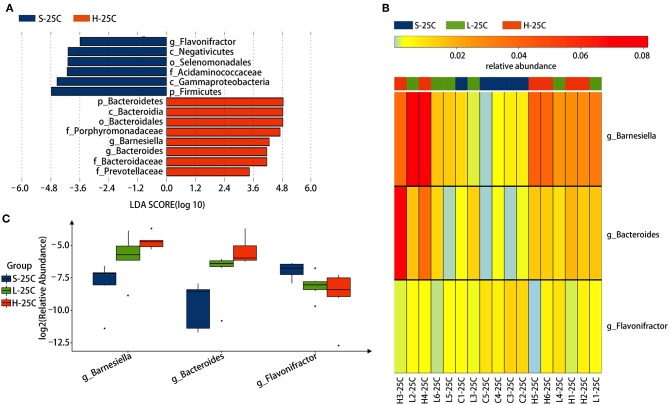
Significant influence of identified cecal microbiota at the genus level on the 25th day post-treatment of spirulina at low and high doses. (A) Histogram of the LDA scores of differential phylotypes abundant among treatment groups according to LEfse analysis; (B) Heatmap and (C) Barplots of the relative abundance of significantly differentiated bacteria among all three treatment groups. S-21C, L-21C, and H-21C represent cecal samples from saline, low, and high dose groups on day 25th, respectively. Differential significant analysis of abundance and composition of gut microbiome was analyzed at the OTUs level by the Kruskal-Wallis test.